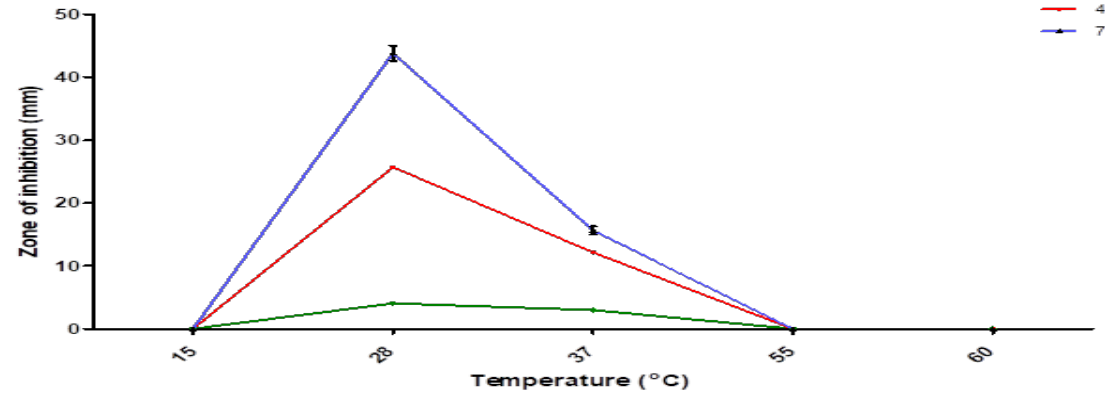
Figure 4. Effect of temperature on the haemolytic activity of Proteus penneri